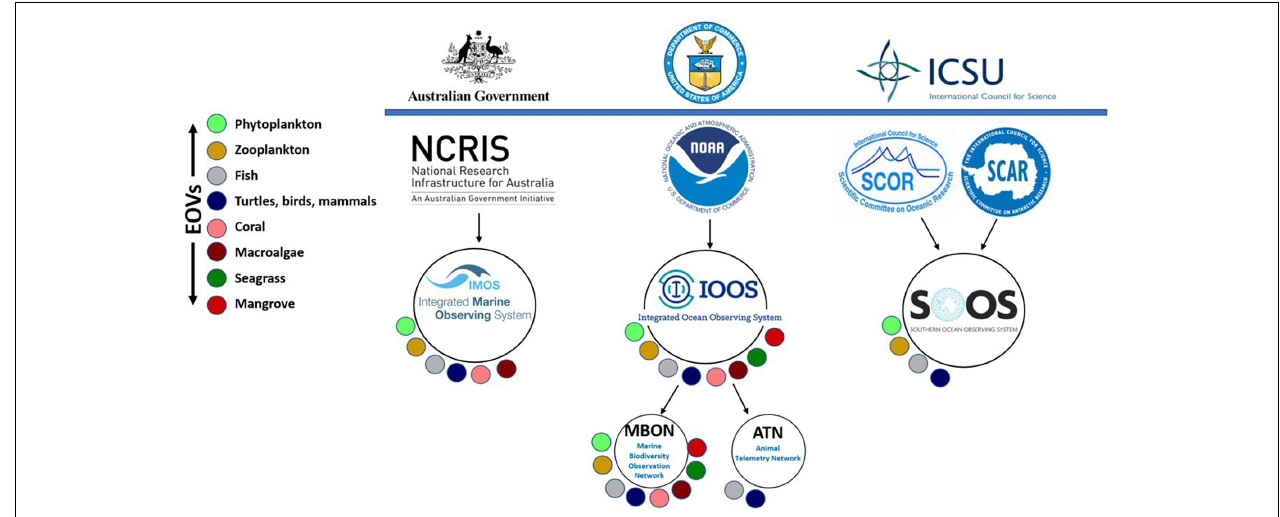
FIGURE 3 | Examples of links between some observing systems and the GOOS BioEco